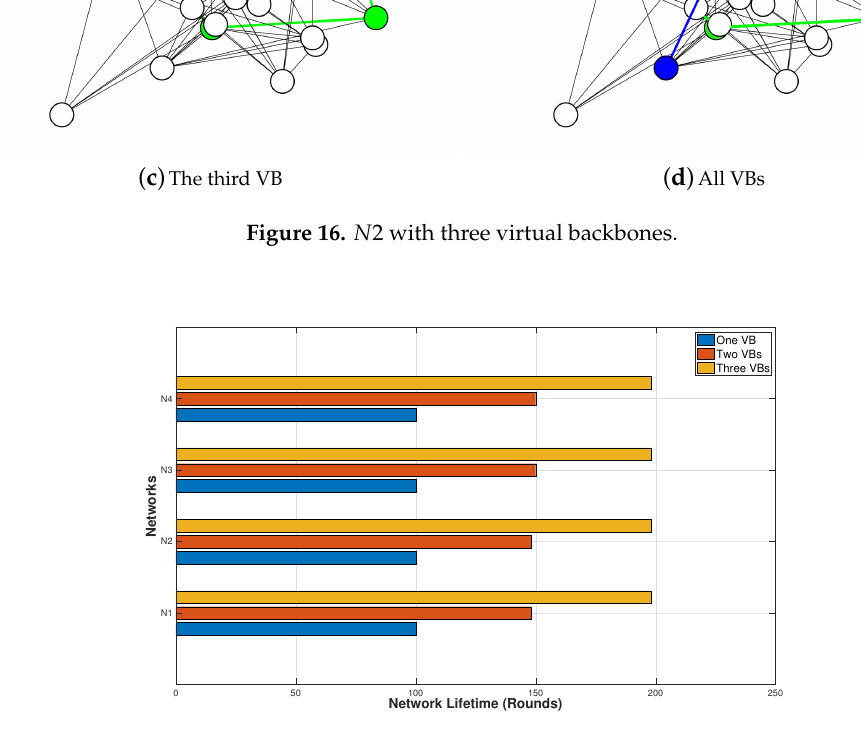
Figure 17. Network